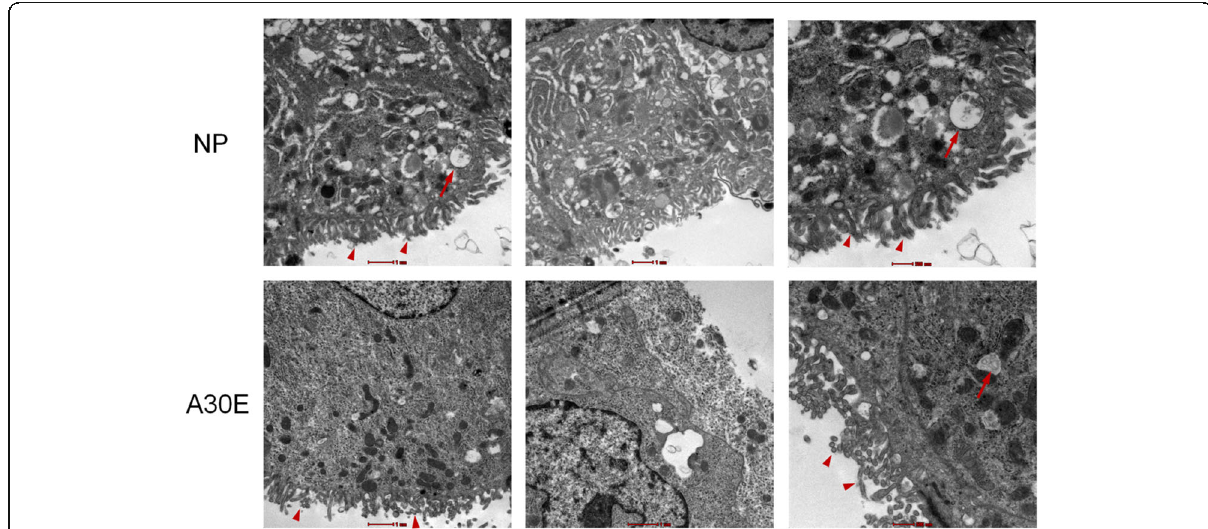
Fig. 5 SEM imaging of maternal decidual epithelium. The decidual tissue is from normal pregnant mice of NP group and aborted mice of A30Z group. The diameter of the tissue, which was fixed in 2.5% glutaraldehyde before preparing ultra-thin section, is 1 mm. After uranium and lead staining, the sections were analyzed by Teneo SEM scanning electron microscope (FEI, U.S.A). Arrowheads indicate microvilli. Arrows indicate pinopodes. Representative images of three samples for each group are shown. The scale bars on the two columns on the left are 1 μ m, and the scale bars on the one column on the right are 500